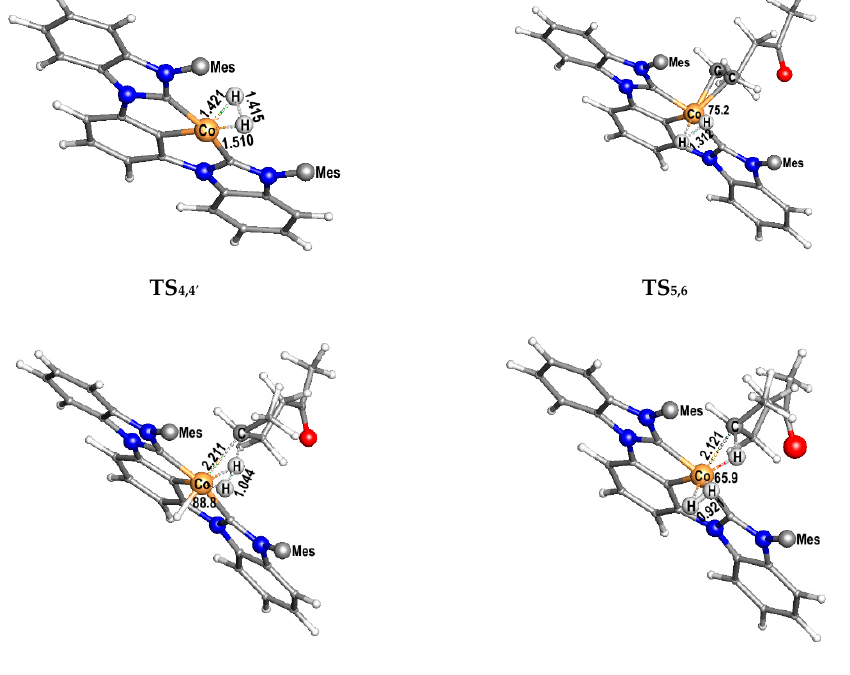
Figure 2. Optimized structures of TS 4,4 ′ (664 i cm − 1 ), TS 5,6 (742 i cm − 1 ), TS 8,4 ′ (1068 i cm − 1 ), and TS 8 ′ ,4 (838 i cm − 1 ). Mesitylene groups are omitted for clarity. Bond lengths are in Å, and bond angles are in °.